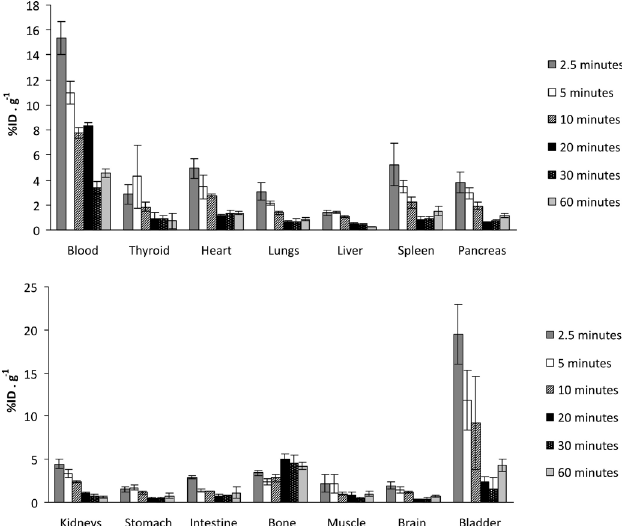
FIGURE 5 - Na 18 F biodistribution profile in Swiss female mice. 70 kBq of Na 18 F were injected into mice ( i.v ). After different time intervals, the animals were sacrificed, blood samples were taken, and thyroid, heart, lungs, liver, spleen, pancreas, kidneys, stomach, intestine, bone, muscle, brain and bladder were removed. Organ radioactivity was measured in an automatic gamma spectrometer and data were expressed as the percentage of total injected dose by tissue weight (% ID.g -1